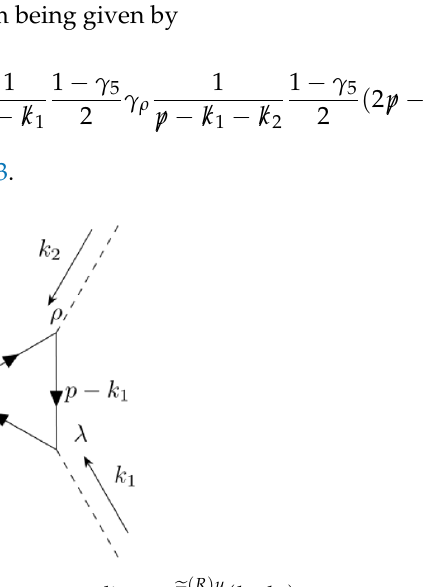
Figure 3. The Feynman diagram corresponding to (cid:101) F